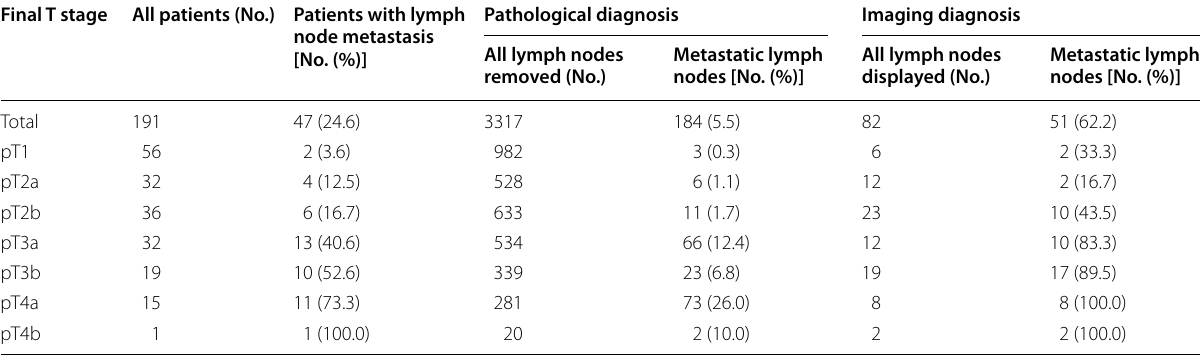
Table 2 Distribution of metastatic lymph nodes in 191 patients with bladder cancer at different T stages Final T stage All patients (No.) Patients with lymph node